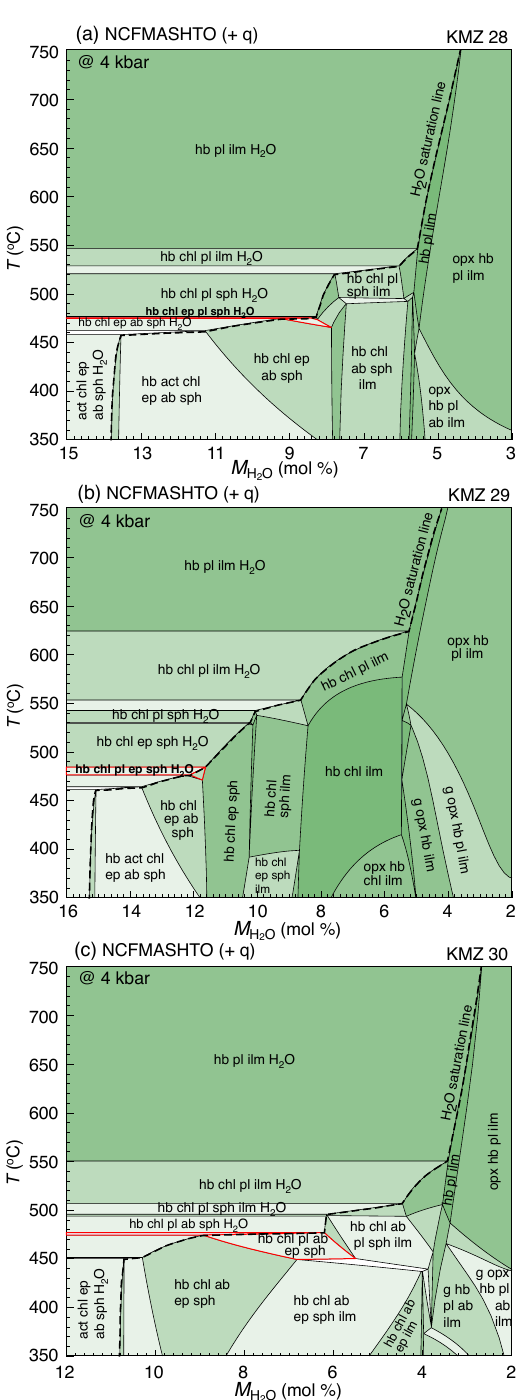
Figure 6. T – M H pseudosections for mafic schists from the 2 O KMZ. H 2 O-saturated assemblages are separated from H 2 O- undersaturated assemblages by the thick dashed line. The observed assemblages are outlined by red